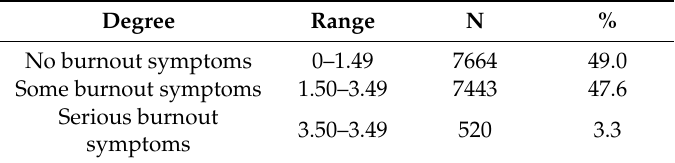
Table 2. Prevalence of job burnout among the workers in rural primary care institutions ( n =